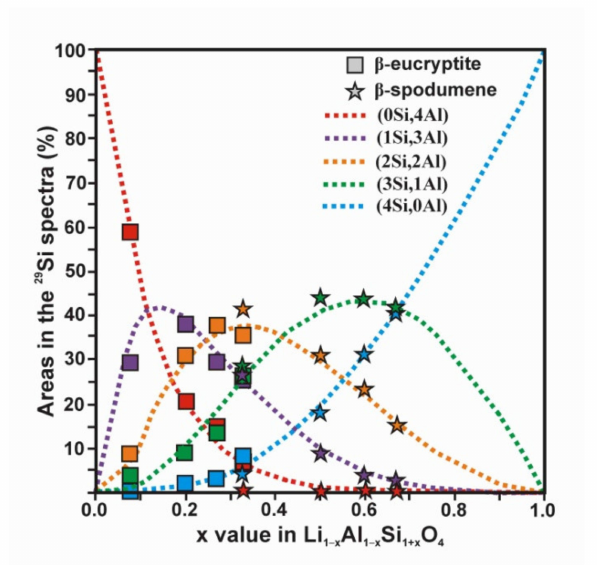
Figure 6. Values of the areas in % of the several components from the deconvolution of 29 Si spectra at 9.4 T against the x value in Li 1 − x Al 1 − x Si 1+x O 4 for samples with β -eucryptite and β -spodumene structures. Dashed lines show the variation of the areas of the five Q 4 n ( n Al) n = 0, 1, 2, 3, and 4 chemical environments according to a Si/Al Loewenstein’s distribution. The probabilities p n ( n is the number of Al atoms around a Si atom) of the five chemical environments are defined by p 0 = (1 − r) 4 ; p 1 = 4(1 − r) 3 r; p 2 = 6r 2 (1 − r) 2 ; p 3 = 4r 3 (1 − r); and p 4 = r 4 , where r = Al/Si. The samples with β -eucryptite structure are represented by squares having different colors for the different chemical environments, whereas the samples with β -spodumene structure are represented by stars.